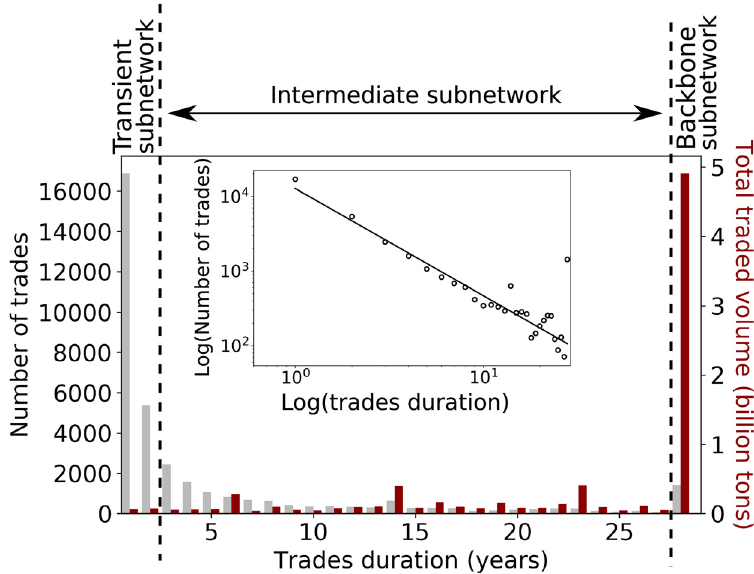
Fig 2. Distributions of the trades duration and their associated traded mass. The distribution of the number of trades (grey) and their associated traded quantities (red) is represented as a function of the number of consecutive years of activity in the period from 1986 to 2013 (28 years). The inset figure shows that, for the world network, the distribution of the number of trades over time fits with a power law with an alpha parameter equal to − 1.44 and a correlation coefficient equal to 0.98. According to the duration distribution of trades we can distinguish three zones. The first zone corresponds to trades of 1 or 2 consecutive years of activity and define the transient subnetwork . The second zone corresponds to trades of 3 to 27 consecutive years of activity and define the intermediate subnetwork . The third zone corresponds to trades that are continuous throughout the 28-years study period and define the backbone network . Most of the traded mass (bars in red) belongs to the backbone